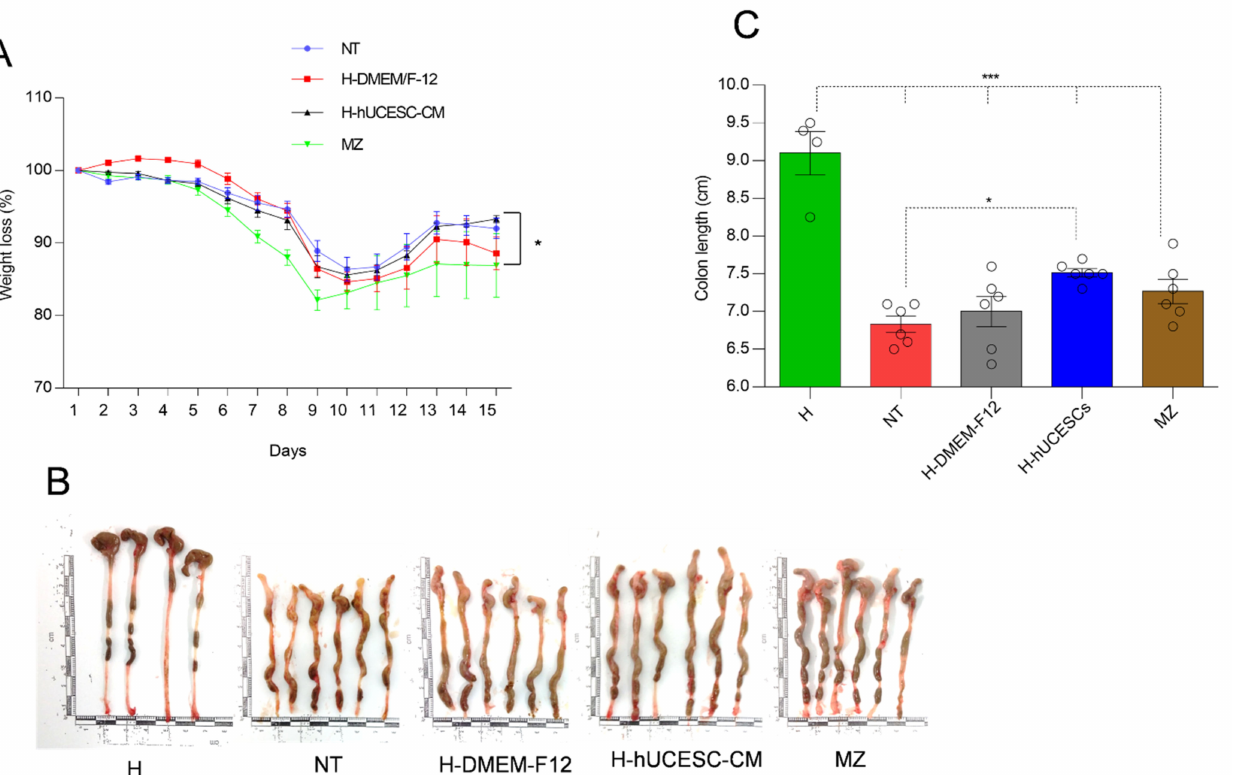
Figure 4. H-hUCESC-CM ameliorates DSS-induced colitis. ( A ) Daily body weight measurement as percentage of starting weight. Asterisk indicates a significant ( p < 0.05) difference in body weight at day 15 between H-hUCESC-CM and MZ mice. ( B ) Colon length images at day 16. ( C ) Colon length values at day 16. DSS-induced colon shortening, however, treatment with H-hUCESC-CM significantly reduced these changes with respect to NT mice. Data are expressed as mean ± SEM. * = p < 0.05; *** = p <